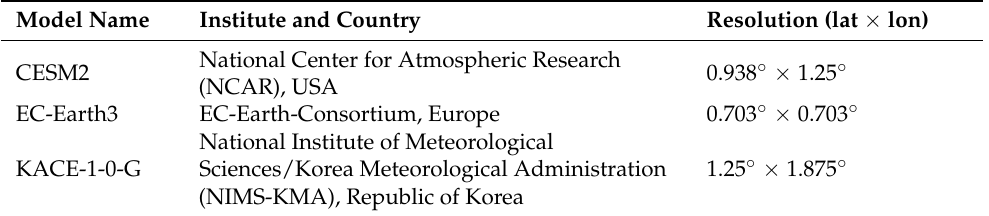
Figure 1. Map of the study area and location of 35 weather stations. Table 1. Main information on selected GCMs from the CMIP6 used in this study.